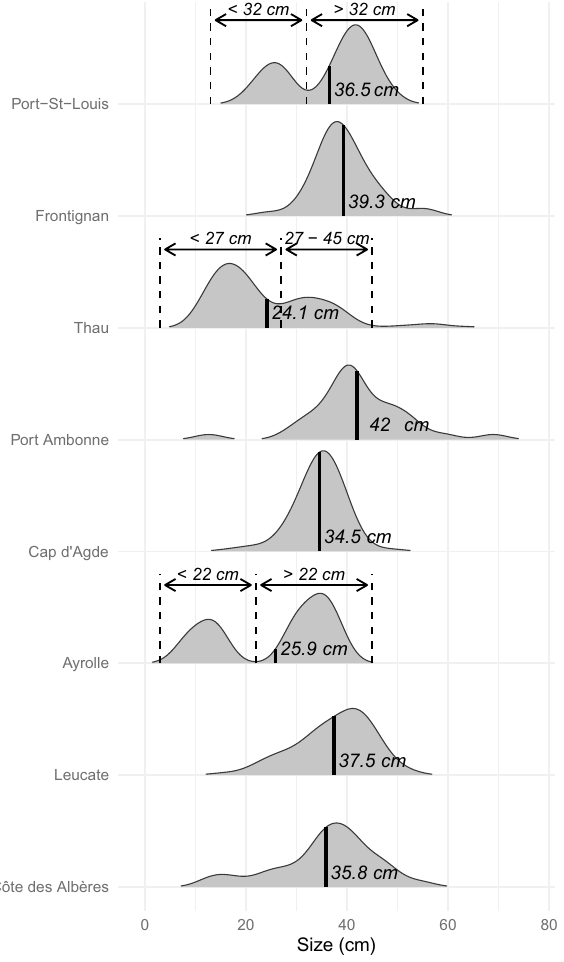
Figure 4. Ridgeline plot showing the size density distribution of Pinna nobilis individuals sampled in each locality. Mean sizes in each locality are represented by solid lines. Arrows represent the range of the size groups identified in Port-St-Louis, Thau and Ayrolle.